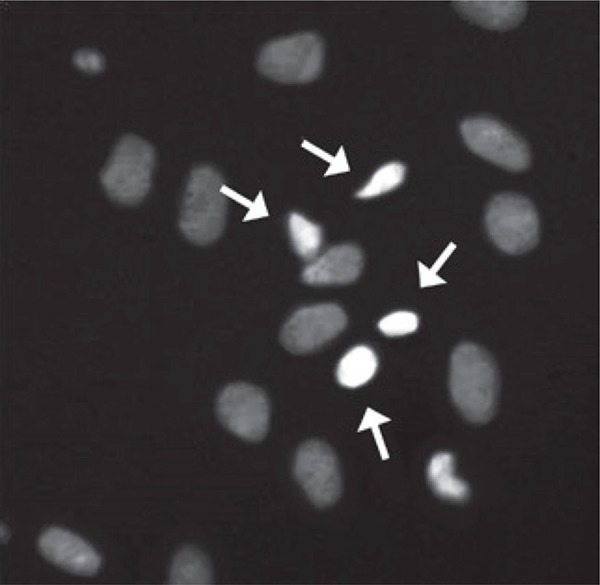
Núcleos de astrócitos marcados com Hoechst 33342 e examinados com microscópio de fluorescência. As setas identificam os núcleos de células mortas, e os núcleos restantes representam células vivas